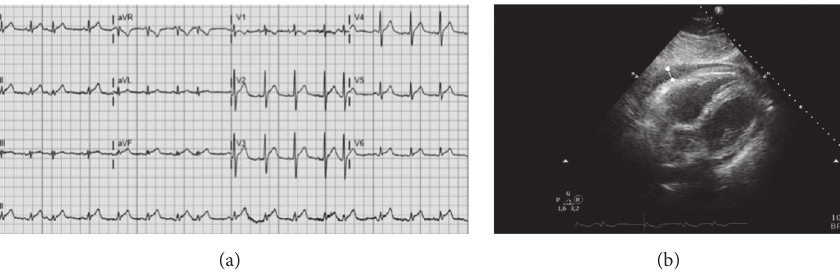
Figure 1: ECG and echocardiography at admission. (a) Twelve-lead ECG during admission shows sinus rhythm and premature atrial contractions in combination with diffuse ST-elevation, typical for acute pericarditis. (b) Ultrasound studies indicated moderate ( < 20mm) pericardial effusion, here shown on the subcostal view and indicated with the white marker.